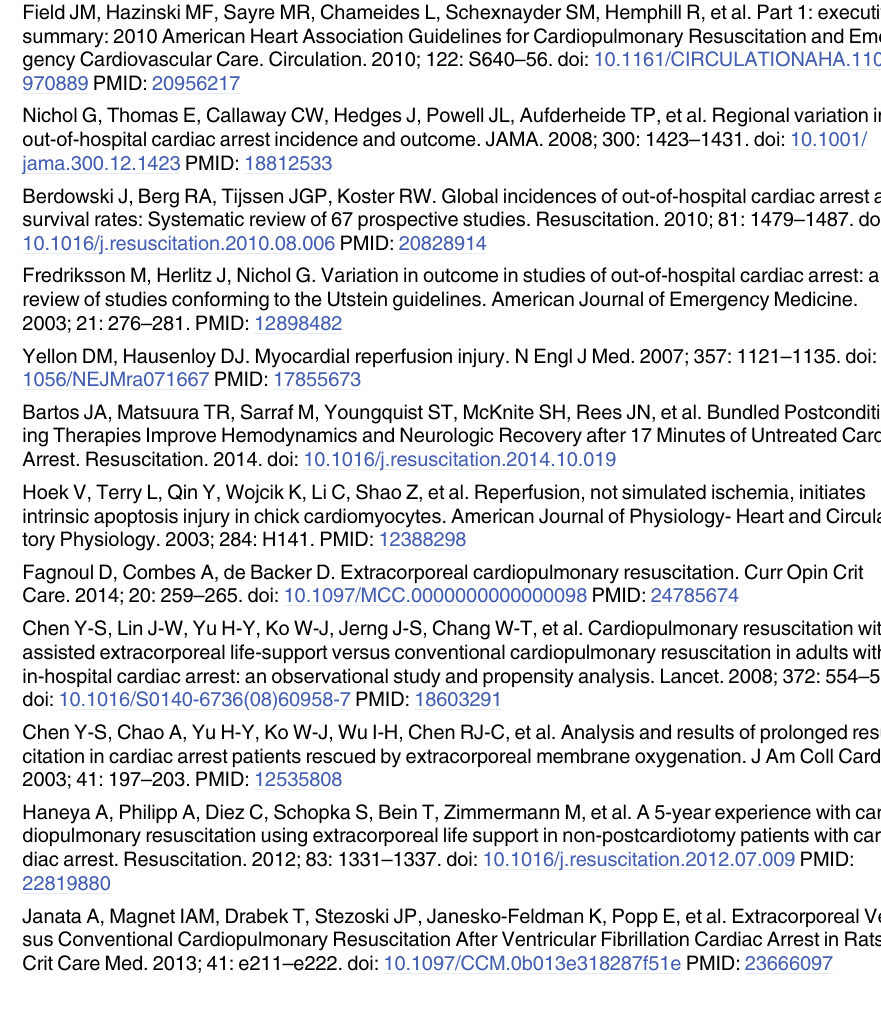
S4 Fig. Reactive brain lesions after implantation of the guiding cannula. Mild mononuclear infiltration of the meninges, edema and gliosis in the cerebral cortex; H&E staining, 100x mag-